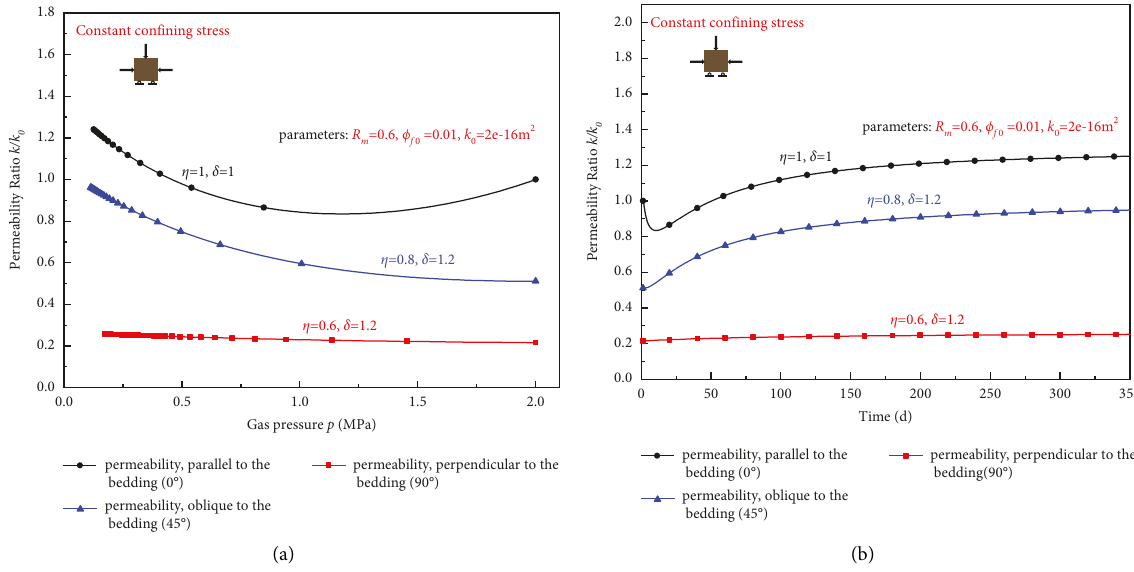
Figure 8: Coal permeability under constant stress boundary condition (a) as a function of gas pressure and (b) as a function of time.